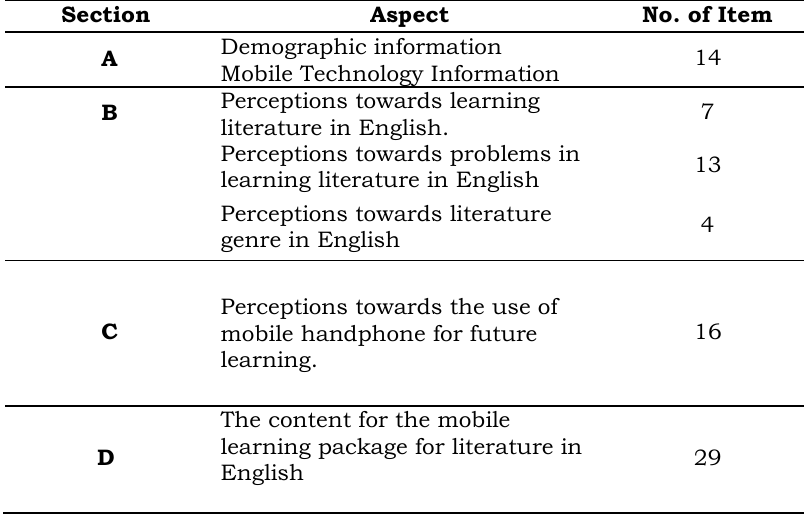
Table 2. The Sections in the Questionnaire for Needs Analysis Survey Section Aspect No. of